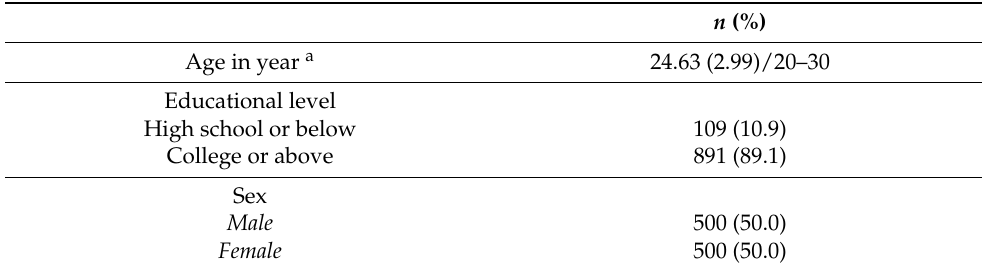
Table 1. Characteristics of the participants ( n =